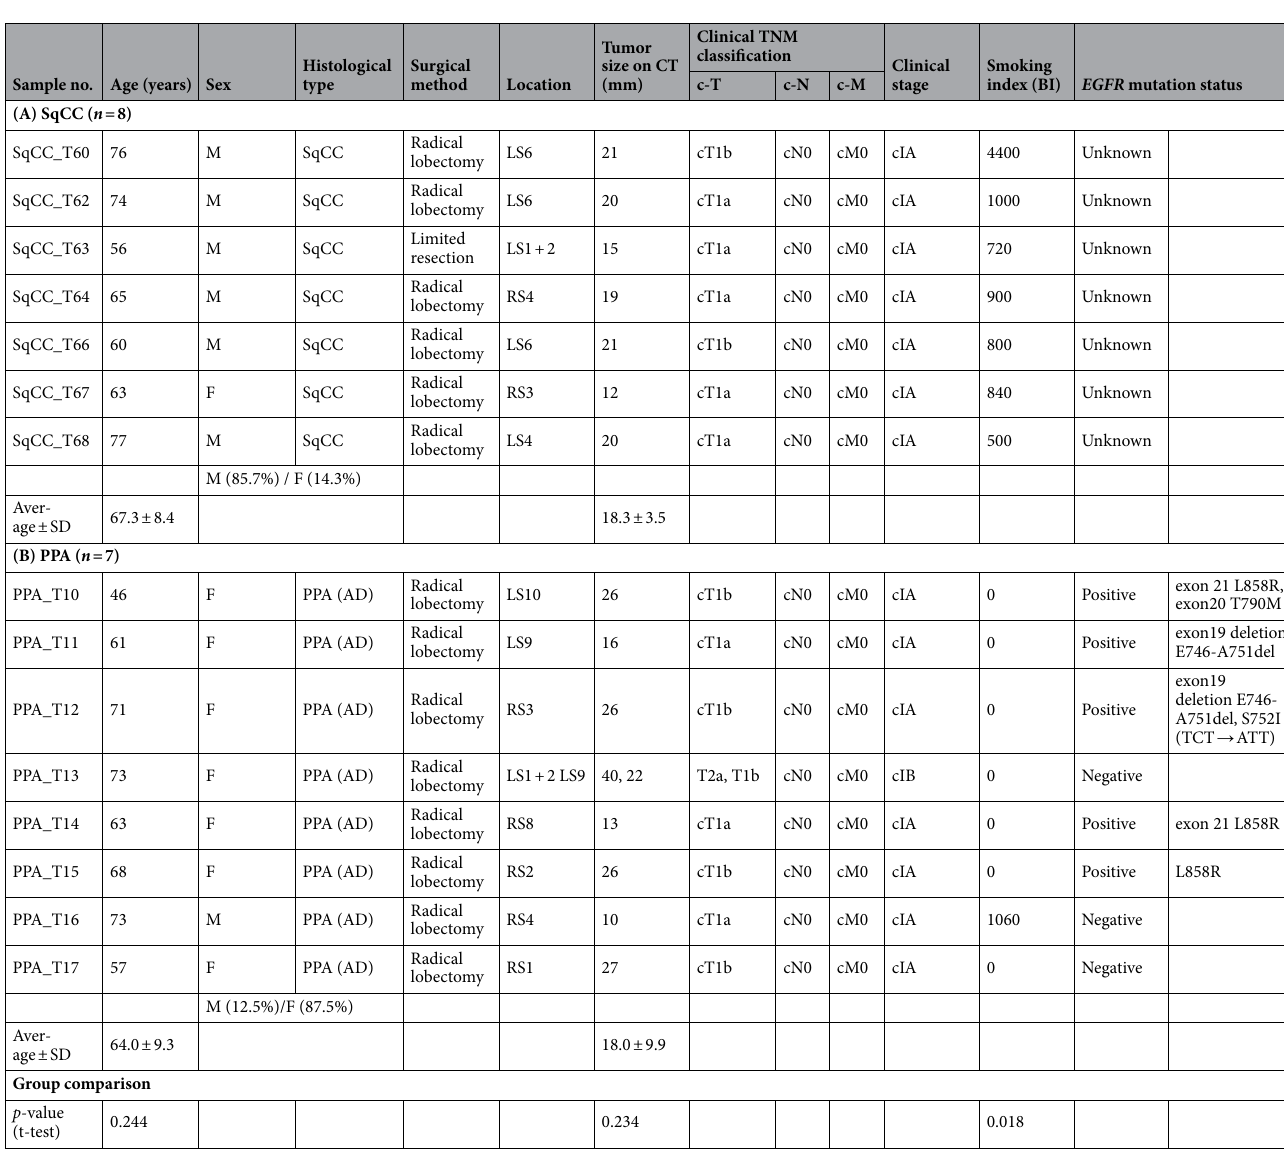
Table 1. Clinicopathological information. SqCC squamous cell carcinoma, PPA papillary predominant adenocarcinoma, AD adenocarcinoma, BI Brinkmann